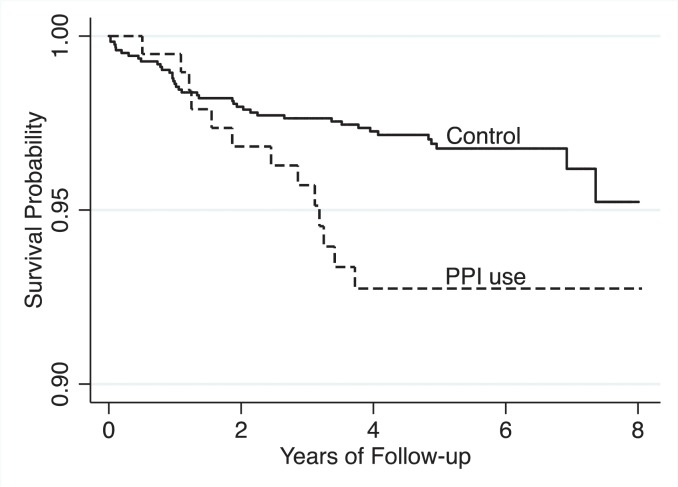
Survival plot from the prospectively followed GenePAD study confirms that PPI use is associated adverse outcome.The Kaplan–Meier curves in the fig show the survival probability from cardiovascular mortality according to PPI usage over an 8 years follow-up period in the ongoing Genetic Determinants of Peripheral Artery Disease (GenePAD) study. PPI usage is associated with a 2.22 fold (CI 1.19–4.16) increased risk of cardiovascular mortality, relative to controls in unadjusted Cox proportional hazards models.